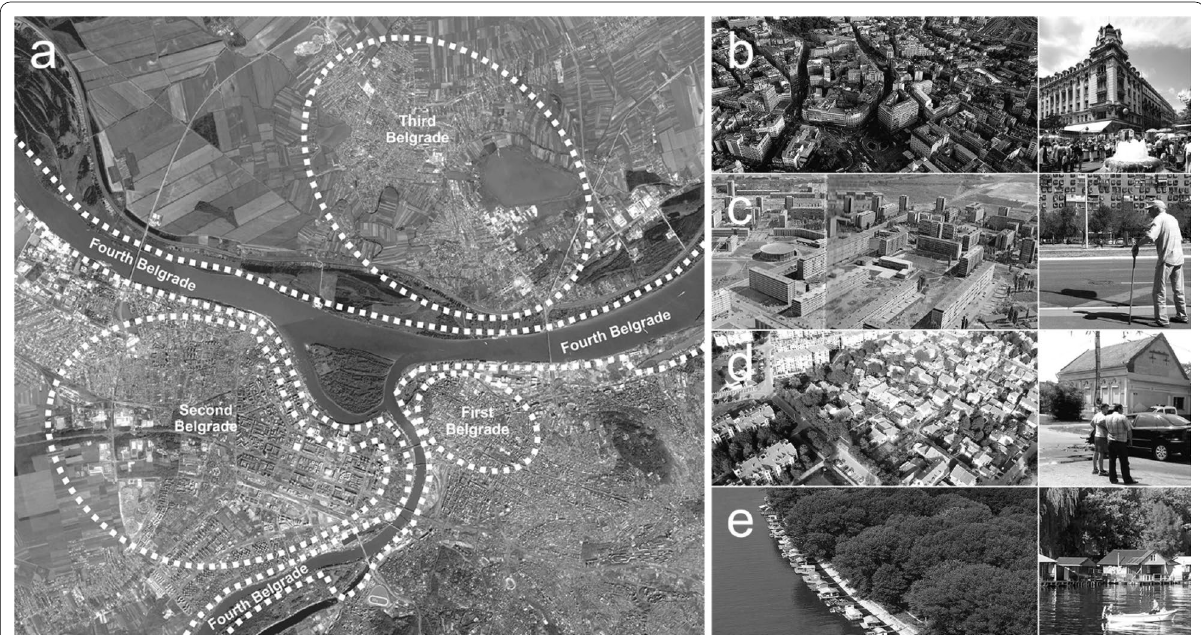
Fig. 1 Unique structure of the city of Belgrade; a the general structure of the city; b First Belgrade—historic center; c Second Belgrade: New Belgrade and Zemun; d Third Belgrade—planned, but prevalently spontaneously developed; e Forth Belgrade—living with the water—rivers as public spaces. Source: Authors elaboration on Đukanović and Giofrè,